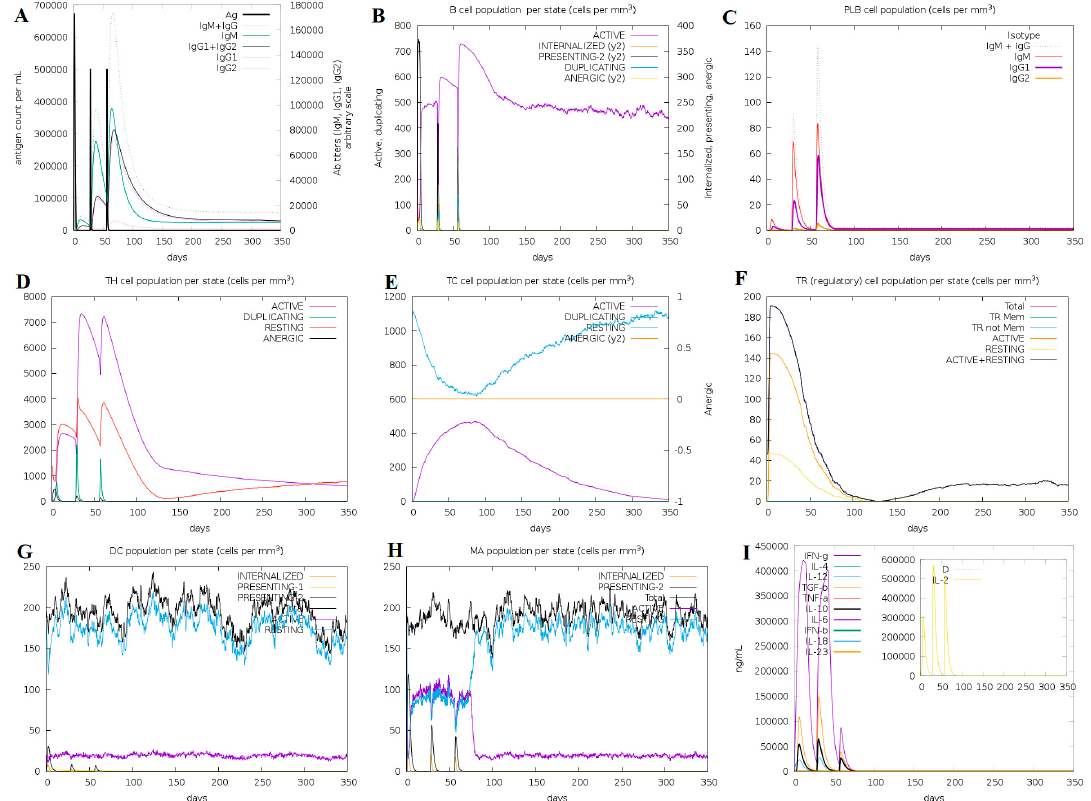
Figure 10. In silico immune response using MEV as antigen: ( A ) generation of immunoglobulins and B-cell isotypes upon exposure to antigen; ( B ) amount of active B-cell populations per state; ( C ) amount of plasma B-lymphocytes and their isotypes per state; ( D ) state of helper T-cell population during subsequent immune responses; ( E ) cytotoxic T-cell population per state of antigen exposure; ( F ) reduced levels of T regulatory cells; ( G ) dendritic cell population per state; ( H ) activity of macrophage population in three subsequent immune responses; ( I ) production of cytokine and interleukins in di ff erent states with the Simpson